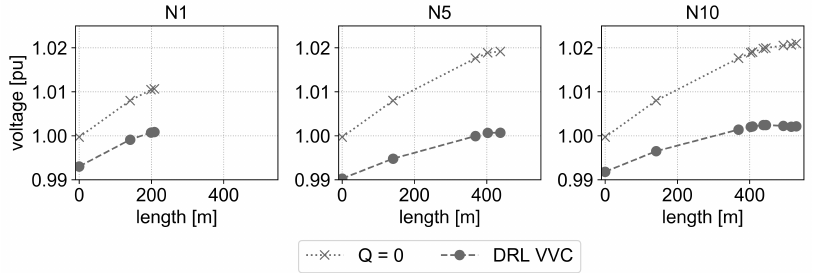
Figure 9. Voltage along the line to nodes N1, N5, and N10 without reactive power feed-in and with DRL VVC at the considered